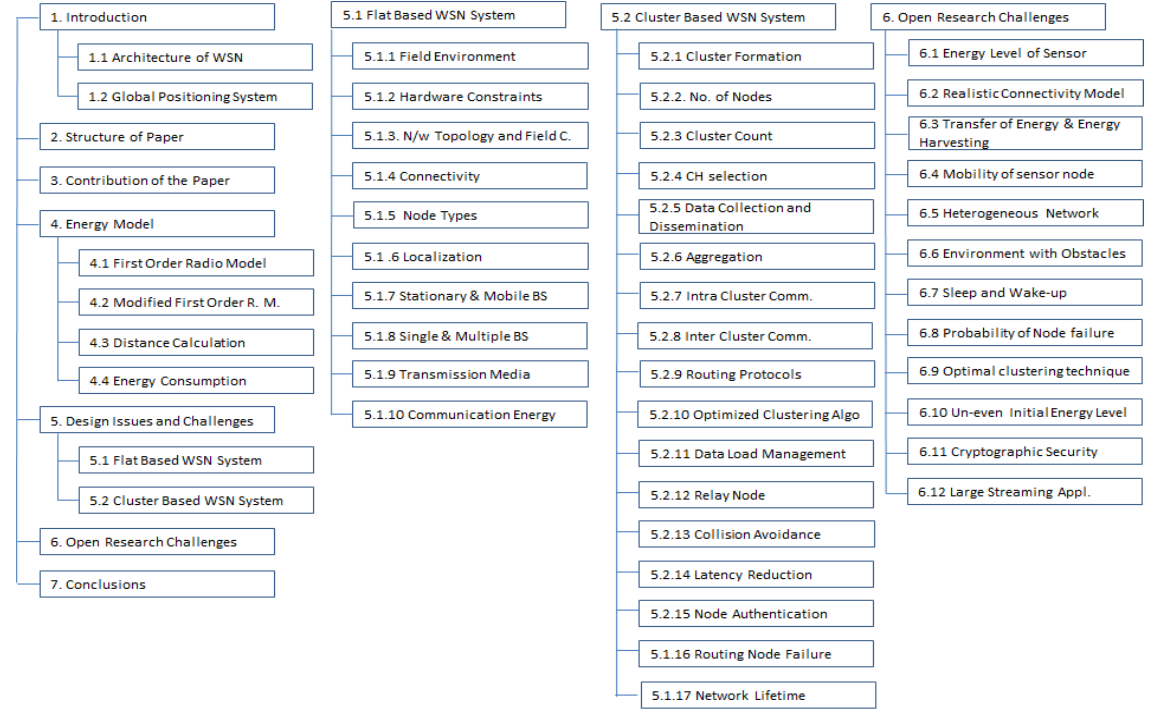
Figure 5. Structure of the